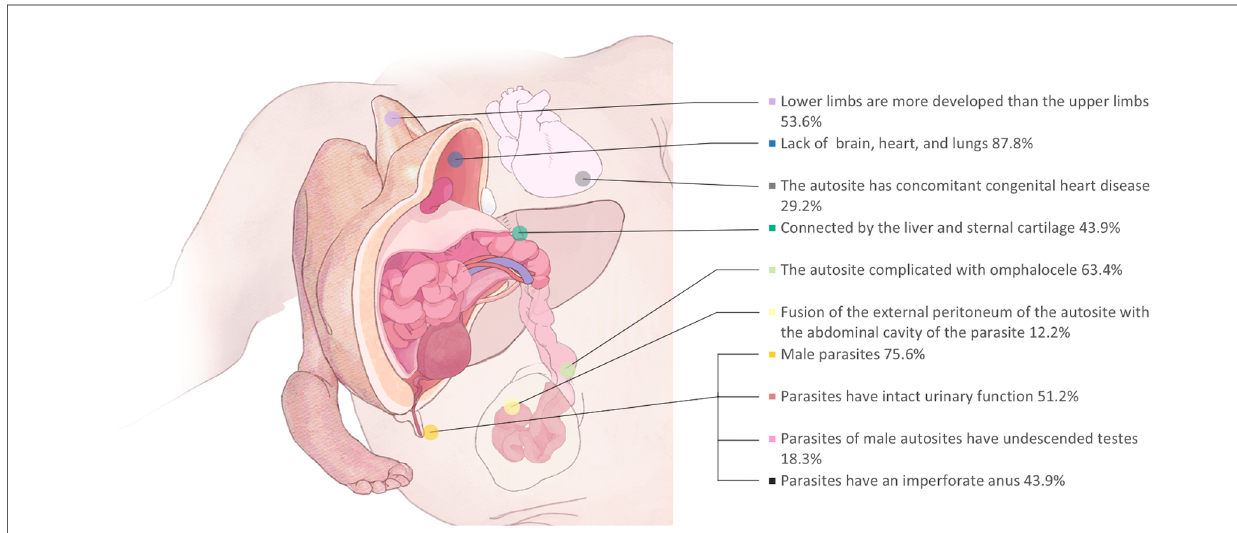
FIGURE 2 Disease characteristics of EHCTs reported in the literature: according to previous literature. Diseases EHCTs are characterized by the incidence of malformations, among which a more important part can be seen that a part of parasitic fetal intestine travels through the abdominal wall of the main body, which needs to be avoided during